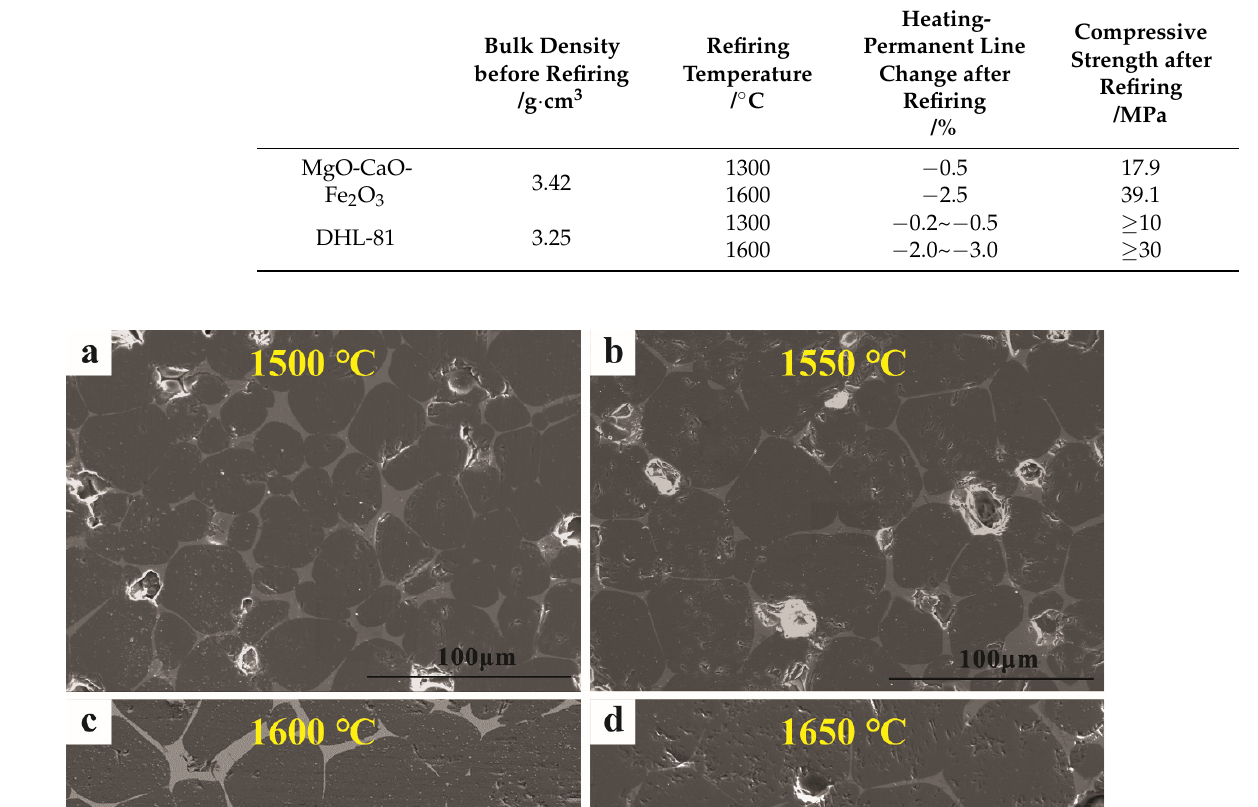
Table 2. Physical properties of MgO-CaO-Fe 2 O 3 clinker fired at 1600 ◦ C.